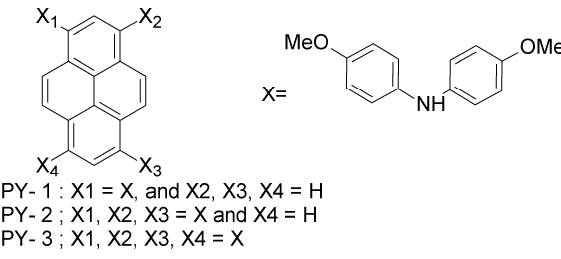
Figure 5. Structures of pyrene-based HTMs: PY-1, PY-2, PY-3. (b) Truxene-core HTMs